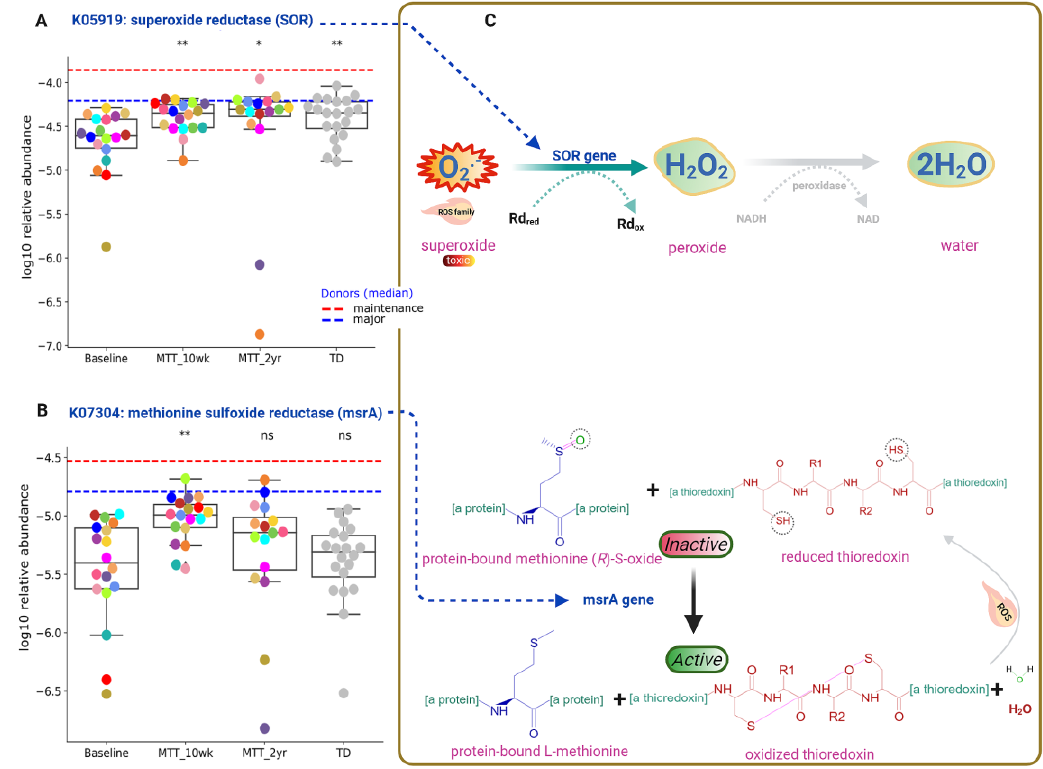
Figure 7. Univariate comparison of the relative abundance (after log 10 transformation) of gut microbiome genes/KOs that encode enzymes involved in oxygen detoxification and oxidative stress before and after MTT in ASD in comparison with TD. ( A ) Oxidative stress protection and detoxification of reactive oxygen species; K05919 ( dfx gene, SOR): superoxide reductase. ( B ) K07304 ( msrA ): peptide-methionine (S)-S-oxide reductase. ( C ) Illustration of enzymatic reactions of SOR and msrA KOs. Dashed lines represent the median of donors. Red-dashed lines represent the mean of maintenance ( n = 2) and blue represents the median of major donors ( n = 5). Colored dots represent ASD individuals and grey-colored ones TD. Asterisks represent significant differences between ASD Baseline and the other groups (* single asterisk indicates p < 0.05; ** double asterisks indicate p < 0.01; ns: not significant; all p -values are FDR-corrected). ASD: autism spectrum disorder; TD: typically developing.